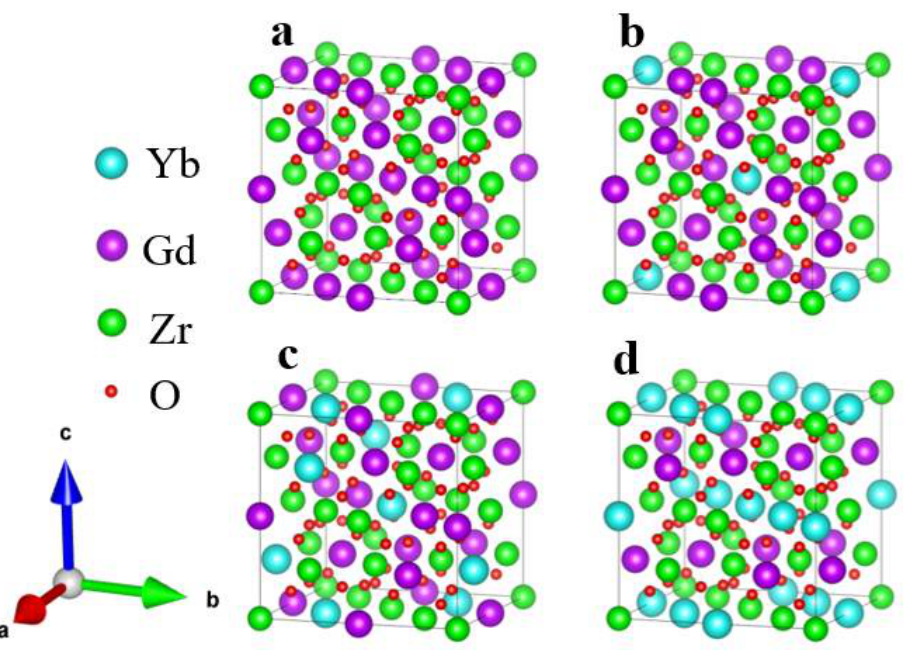
Figure 2. Geometrical configurations of (Gd 1-x Yb x ) 2 Zr 2 O 7 , ( a ) Gd 2 Zr 2 O 7 ; ( b ) (Gd 0.875 Yb 0.125 ) 2 Zr 2 O 7 ; ( c ) (Gd 0.6875 Yb 0.3125 ) 2 Zr 2 O 7 ; ( d ) (Gd 0.5 Yb 0.5 ) 2 Zr 2 O 7 .